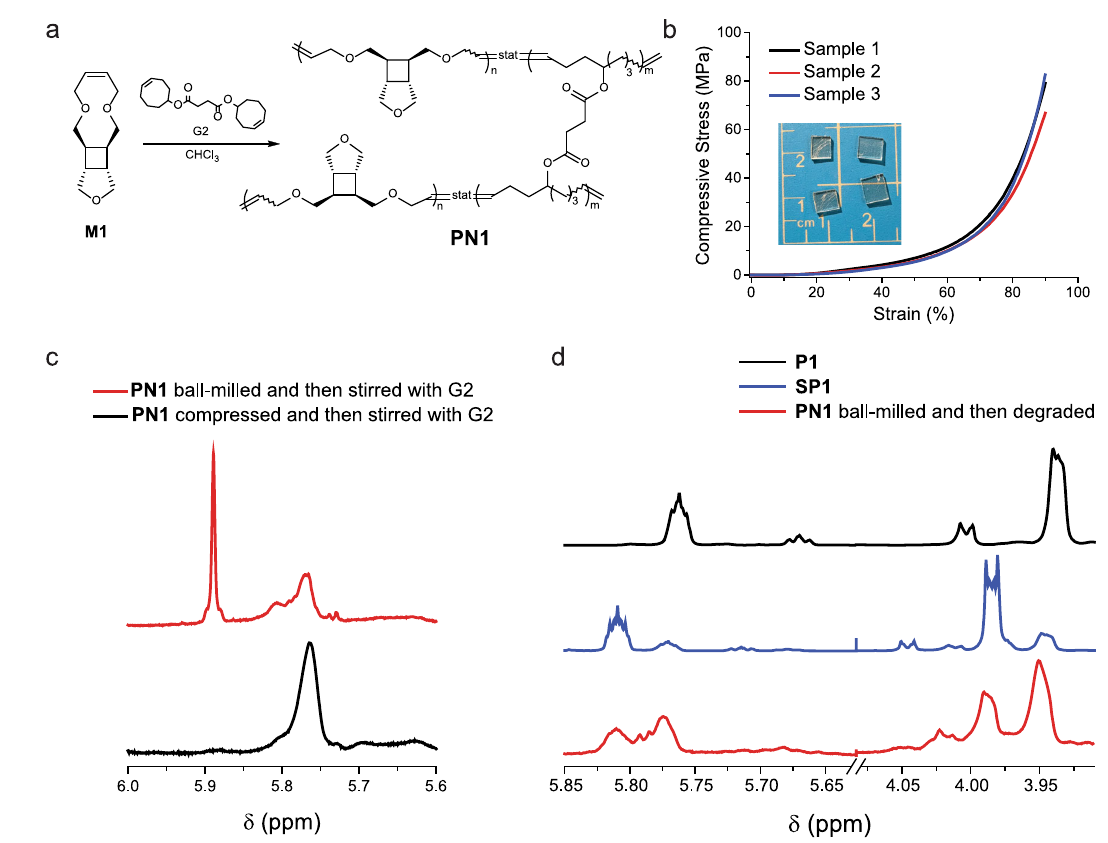
Fig. 9 | Mechanochemical activation in polymer network PN1 . a Synthetic schemeof PN1 . b Pictureof PN1 thin fi lmandthestress – straincurveobtainedfrom compressive testing of the fi lm (sample 1, black; sample 2, red; sample 3, blue).